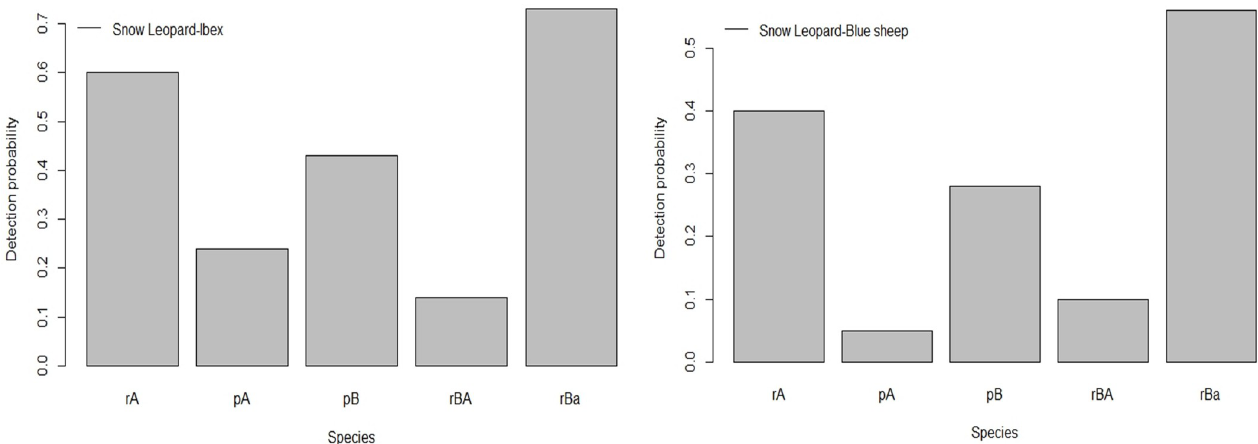
Fig 4. Influence of snow leopard on detection of its prey species, where: rA (probability of dominant species detection in the presence of subordinate), pA (detection probability of the dominant species in the absence of subordinate species), pB (detection probability of subordinate species in the absence of dominant species), rBA (detection probability of subordinate species in the presence and detection of dominant species), rBa (detection probability of subordinate in the presence and without detection of dominant species).